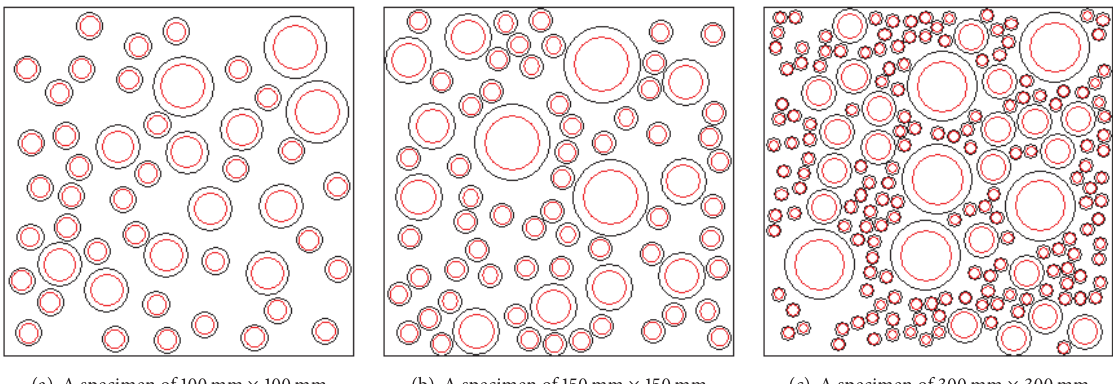
Figure 3: Random circular aggregate model of RAC.